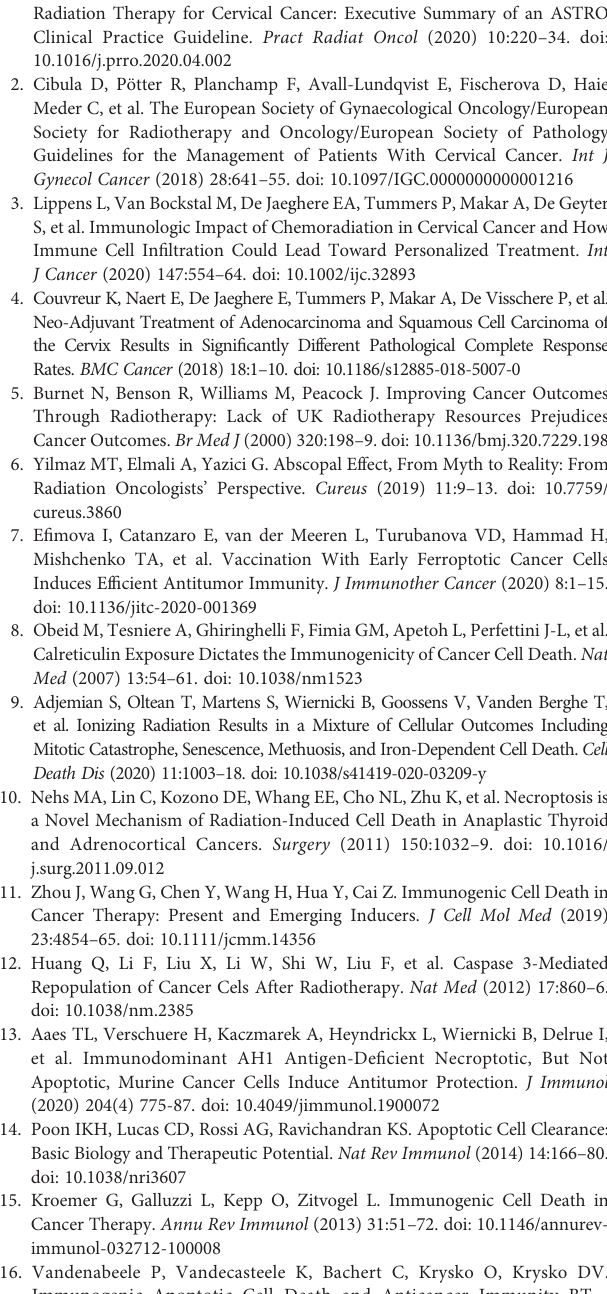
markets, DAMPs, Age, FIGO and lymph-node status with Relapse or CSS are shown in the biopsy samples (pre-treatment), the hysterectomies (post-treatment) and the treatment-induced levels (hysterectomy sample levels - biopsy sample levels). P-values and p-values FDR-corrected are shown for each association. DAMPs, damage-associated molecular patterns; pMLKL, phosphorylated mixed lineage kinase domain like pseudokinase; HMGB1, High Mobiliy Group Box 1; 4-HNE, 4-hydroxynonenal; GPX4, glutathione peroxidase 4; FIGO, (International Federation of Obstetrics and